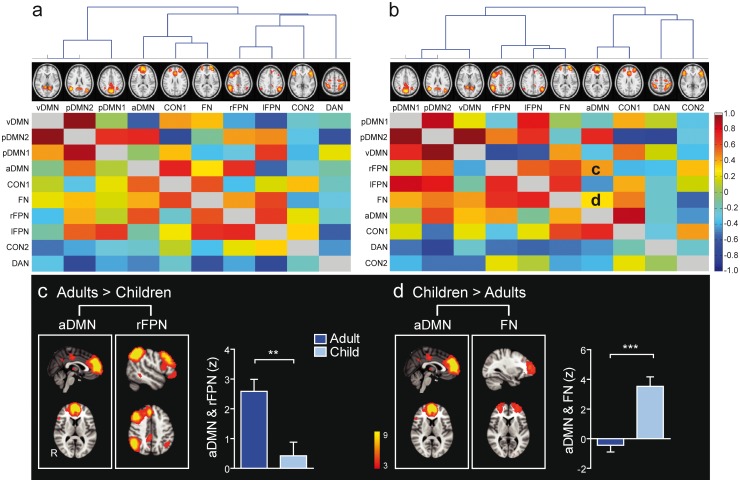
Hierarchical clustering, full and partial correlations and group differences in between-network FC of the ICNs.Hierarchical clustering of the neurocognitive networks of the combined group data during (a) resting state and (b) task performance. Full and partial correlations between the ICNs representing neurocognitive networks are displayed below and above the main diagonal, respectively. (c) Adults compared to children showed stronger connectivity between the aDMN and rFPN during tasks (indicated by letter c in panel b). (d) Children compared to adults had stronger connectivity between the aDMN and the frontopolar network during tasks (indicated by letter d in panel b). The significance level of all comparison analyses was multiple comparison corrected at p < 0.05 with cluster size > 10 contiguous voxels. The columns in c and d illustrate the mean FC between the networks that differed significantly between the groups. CON, cingulo-opercular network; DAN, dorsal attentional network; DMN, default mode network; FN, frontopolar network; FPN, frontoparietal network; a, anterior; p, posterior; v, ventral; l, left; R, r, right; ** p < 0.01, *** p < 0.001 (unpaired t-test).